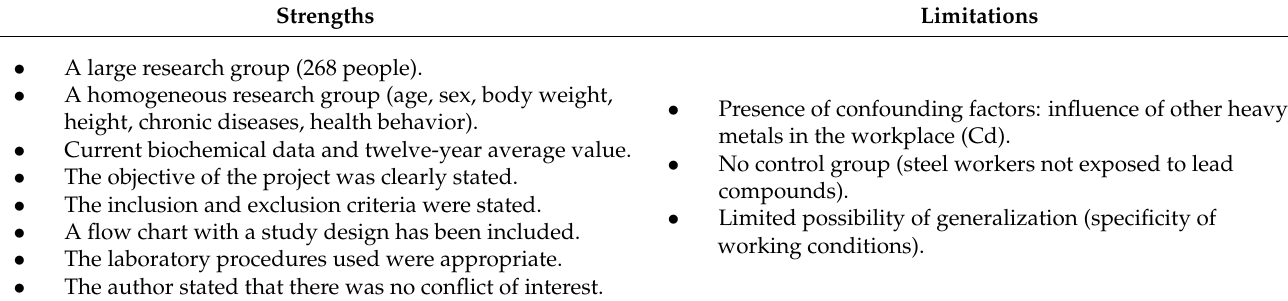
Table 6. Strengths and limitations of this